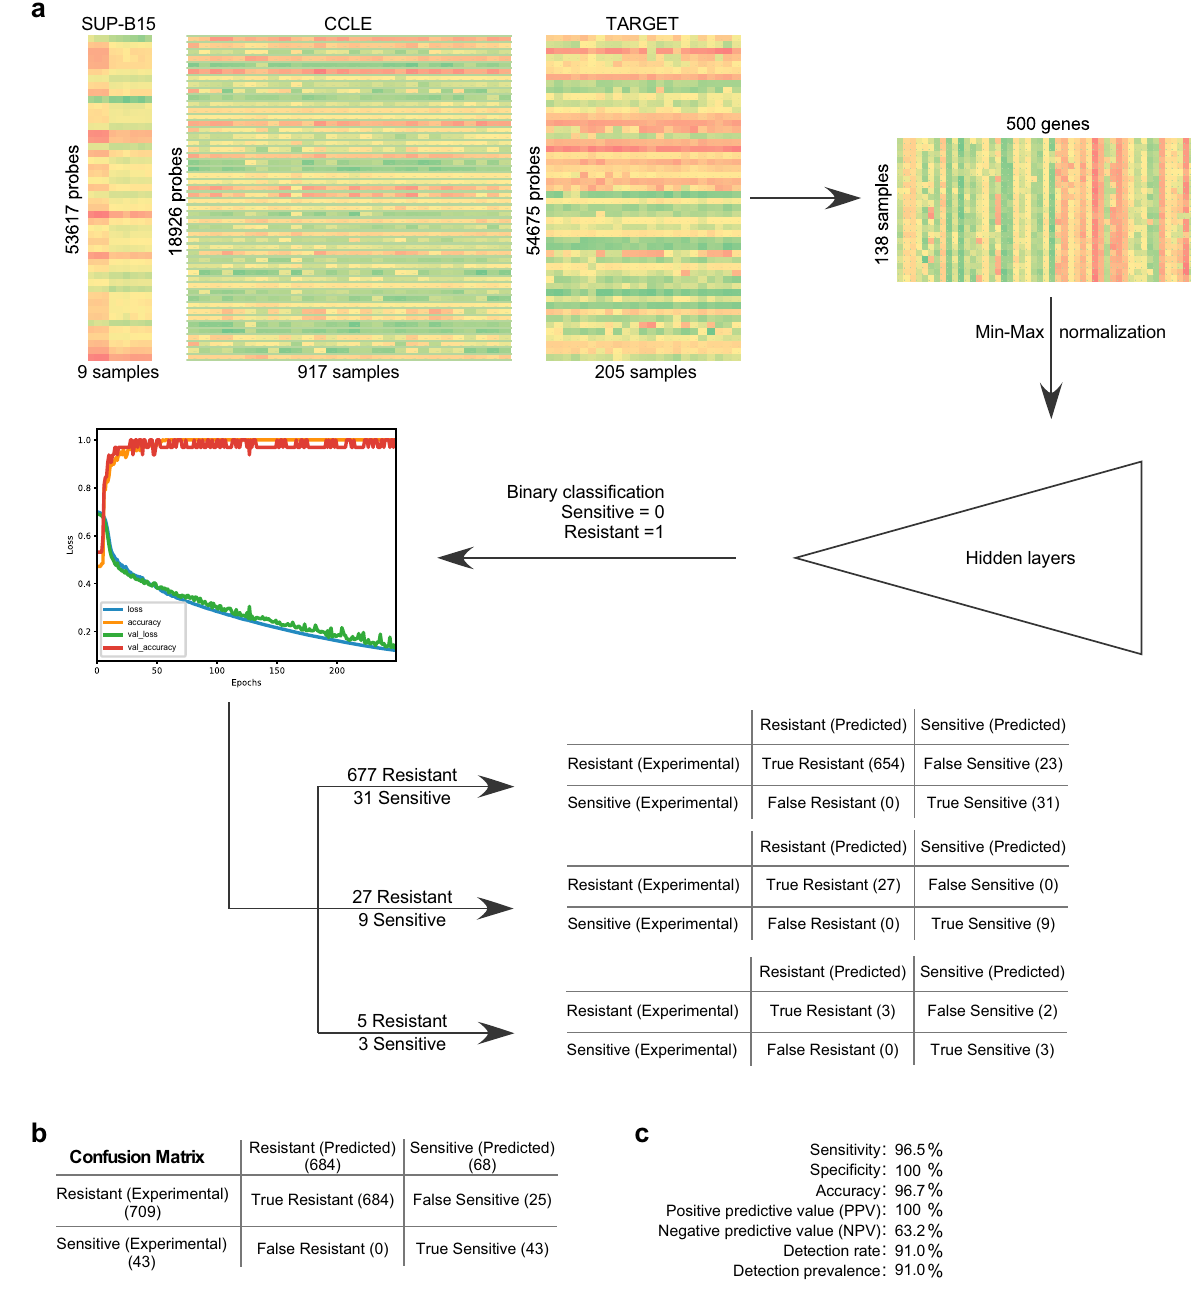
Fig. 3 Dexamethasone sensitivity prediction model. a Deregulated gene signatures from dexamethasone- and prednisolone-treated SUP- B15 cells were combined with genes displaying the highest level of variation in CCLE and TARGET (ALL) datasets and 500 genes were selected. The 500 genes from 138 cell lines of hematological malignancies were used to build a deep learning model. The model was tested using three sets of samples. b Confusion matrix for all three groups of samples. c The performance of the model was calculated using three test sample